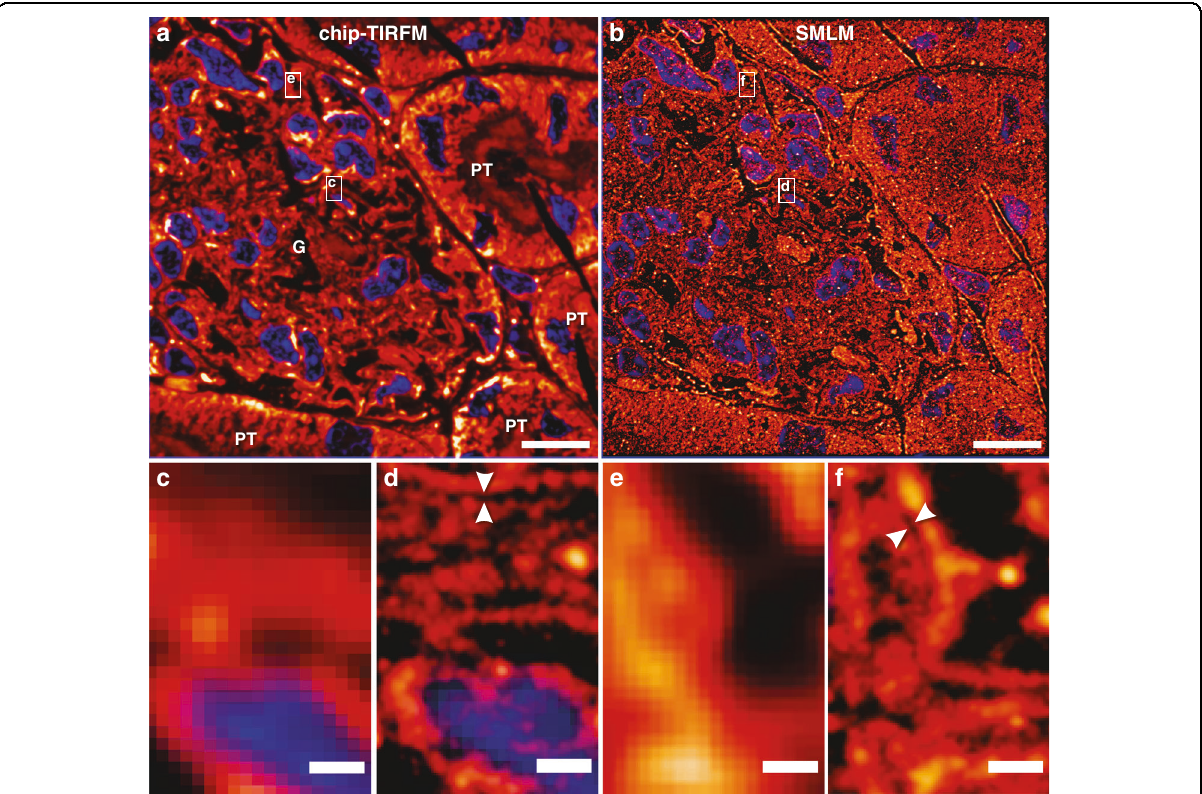
Fig. 3 Chip-based single-molecule localization microscopy of a 400 nm mouse kidney cryosection prepared by Tokuyasu method. Membranes labeled with CellMask Deep Red (pseudo-colored in orange) and nuclei labeled with Sytox Green (pseudo-colored in blue). Images were collected using a 60X/1.2NA water immersion microscope objective. a Chip-TIRFM image of a glomerulus (G) surrounded by proximal tubuli (PT). b Chip-based SMLM image reconstructed with the dSTORM algorithm. c – f A magni fi ed view of the white rectangles in ( a , b ) allows the comparison between the chip-TIRFM and dSTORM images. In particular, the white arrowheads in the SMLM segments show a separation of ~100 nm between cellular structures that are otherwise not observable in the TIRFM segments. Arguably, this nanostructural feature is in agreement with the dimensions of the glomerular basal membrane present in this fi ltration compartment of the kidney. Scale bars a , b 10 µm, c 500